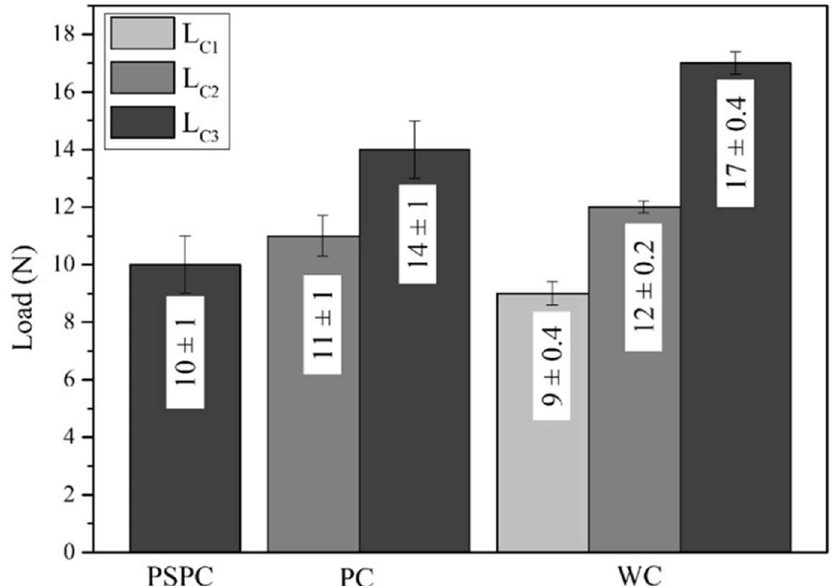
Figure 11. Critical loads achieved at ramped loads for the hybrid, printed and coated and wrought and coated.